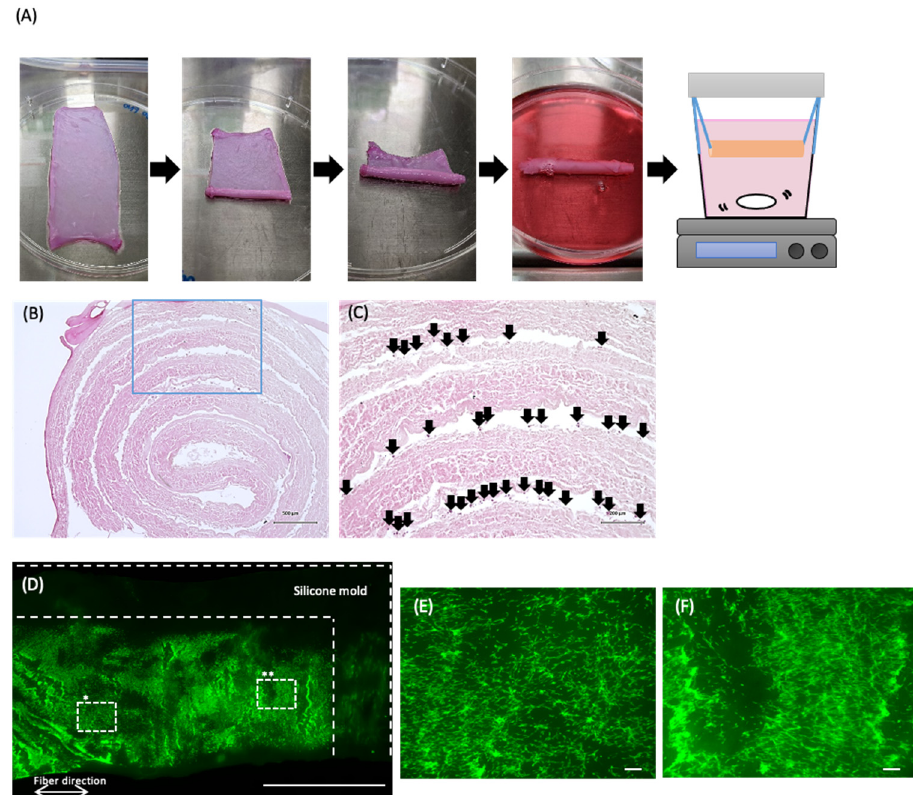
Figure 8. ( A ) Cylinder formation of the recellularized pericardium with C2C12 cells at a cell density of 2 × 10 3 cells/cm 2 and hanging culture. ( B , C ) H&E staining of the cross-section of the hanging- cultured pericardium for 2 days. The arrows show cells. ( D – F ) Fluorescent images of the Calcein- AM-stained cells on the partially peeled pericardium from the cylindrically formed pericardium after hanging culturing. ( E , F ): * and ** of hash square regions. Scale bars: ( D ) 1 cm, ( E , F ) 200 µm.